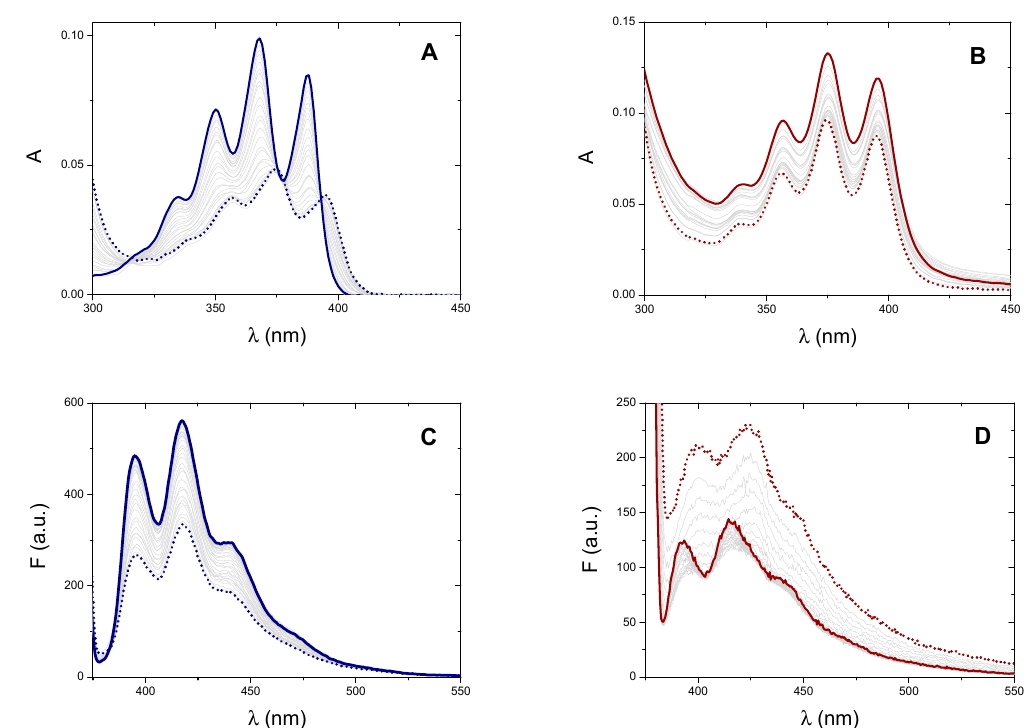
Figure 2. Absorption spectra in the presence of increasing amounts of CT-DNA of ( A ) [Ag(EIA) 2 ] + 7.96 × 10 − 6 M alone (full line) and DNA from 0 M to 5.89 × 10 − 4 M (dotted line), ( B ) [Au(EIA) 2 ] + 4.34 × 10 − 5 M alone (full line) and DNA, from 0 M to 3.55 × 10 − 4 M (dotted line). Fluorescence spectra in the presence of increasing amounts of CT-DNA of ( C ) [Ag(EIA) 2 ] + 7.86 × 10 − 8 M alone (full line) and DNA from 0 M to 7.13 × 10 − 5 M (dotted line), λ ex = 368 nm, ( D ) [Au(EIA) 2 ] + 7.71 × 10 − 6 M alone (full line and DNA from 0 M to 8.16 × 10 − 4 M (dotted line), λ ex = 375 nm. NaCl 0.1 M, NaCac 2.5 mM, pH = 7.0, T = 25.0 °C.